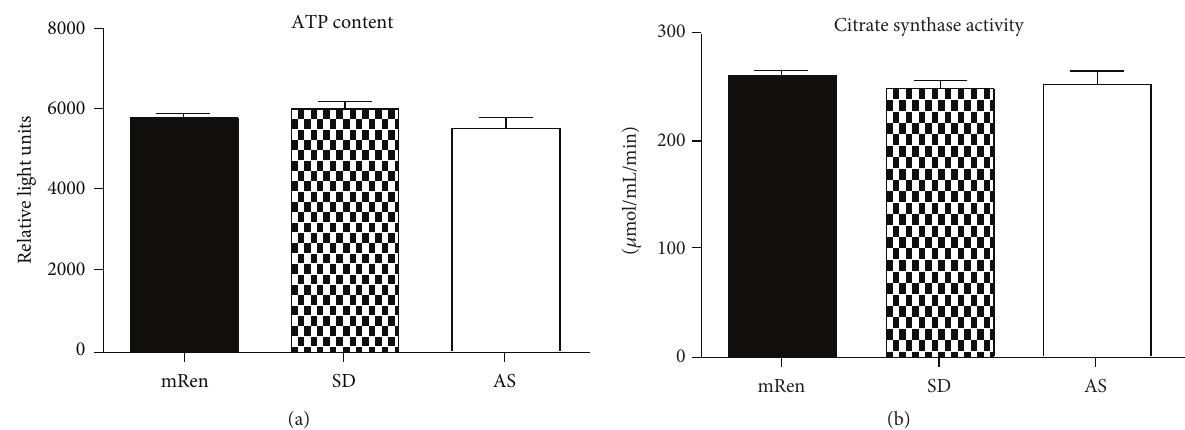
F 5: Brain dorsal medullary ATP levels (a) and mitochondrial content as measured using citrate synthase (b) was not different among hypertensive (mRen2)27 [mRen], Sprague-Dawley (SD) or hypotensive ASrAOGEN (AS) rats. ATP levels were determined using a chemiluminescent assay (Promega) and citrate synthase activity was measured using the assay kit (Sigma) in tissue homogenates. Mean SEM ( per 𝑛𝑛 𝑛 𝑛